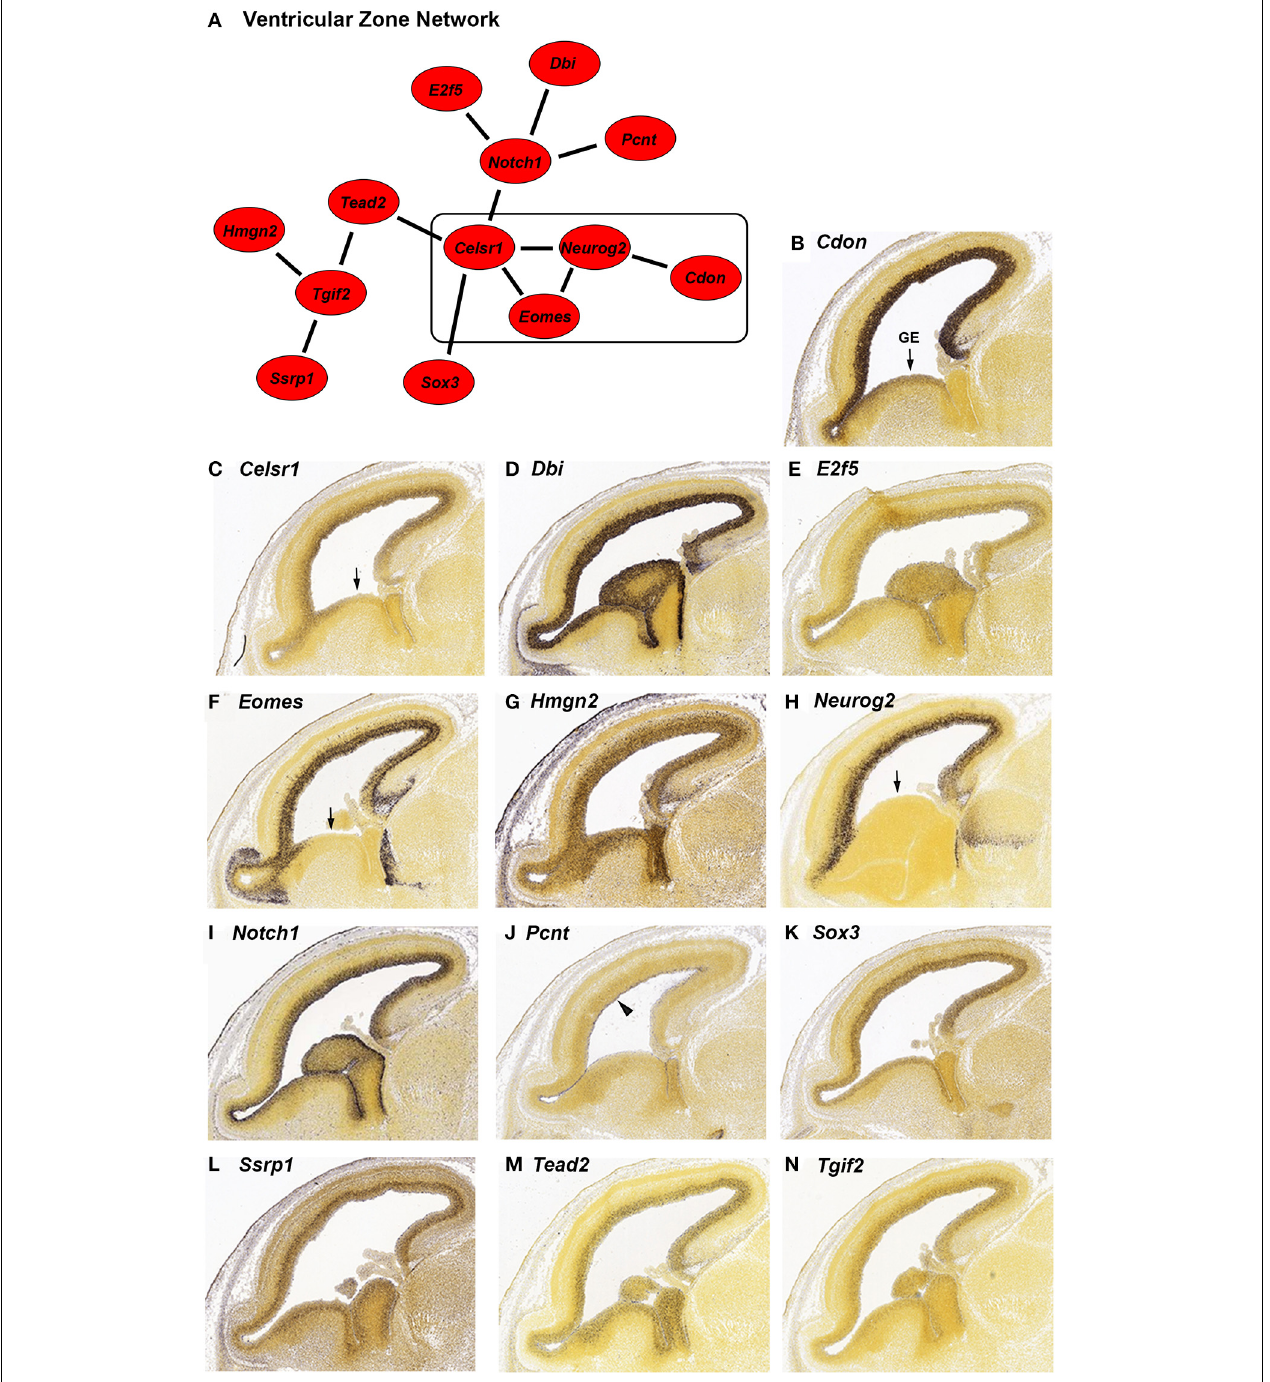
FIGURE 1 | In situ hybridization (ISH) of genes highly expressed in the ventricular zone (VZ) during embryonic development from the Allen Developing Mouse Brain Atlas. (A) Network of genes with high differential expression in the VZ of the mouse brain at age E15.5. The strength of correlation between the genes was at least an r -value of 0.7. The rectangle indicates genes with reduced expression in the ganglionic